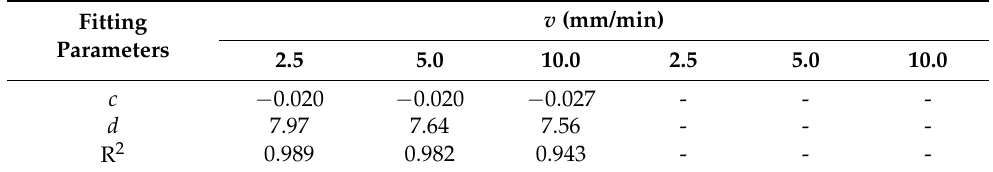
Figure 8. Relationship between K and initial strain ε 0 at three tensile rates. Table 4. Fitting parameters by fitting a line between K and initial strain ε 0 .